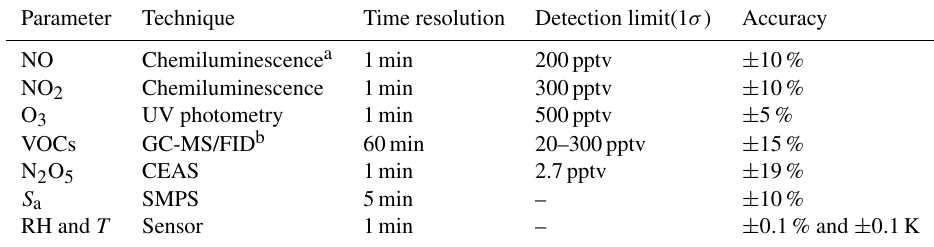
Table 1. Performance of related instruments incorporated in the flow tube system.